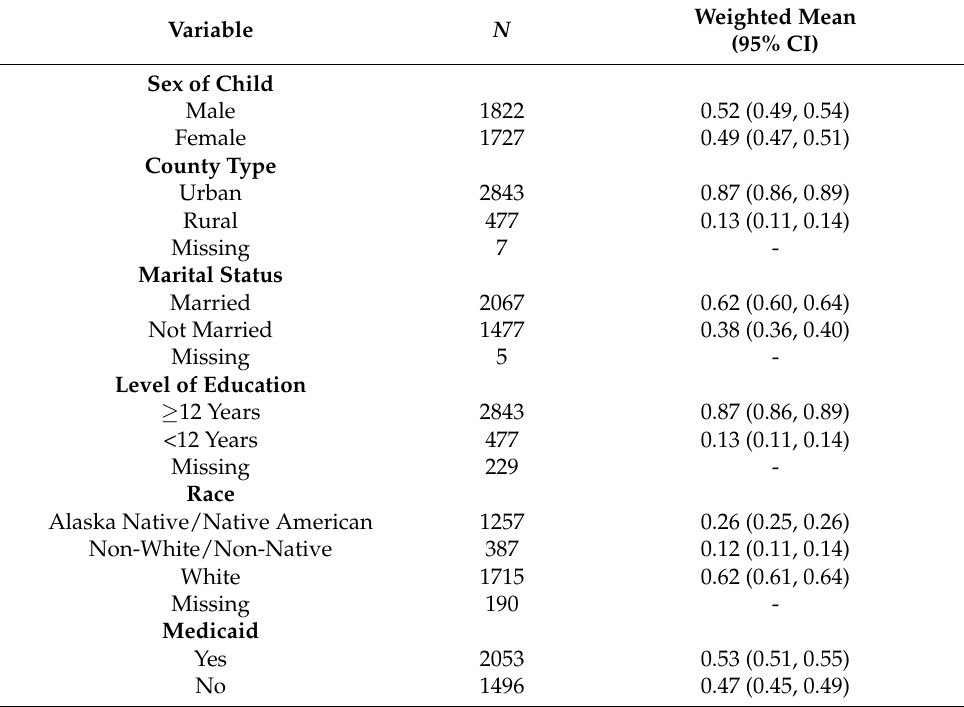
Table 1. Demographic characteristics of PRAMS respondents (birthing parents) and offspring.